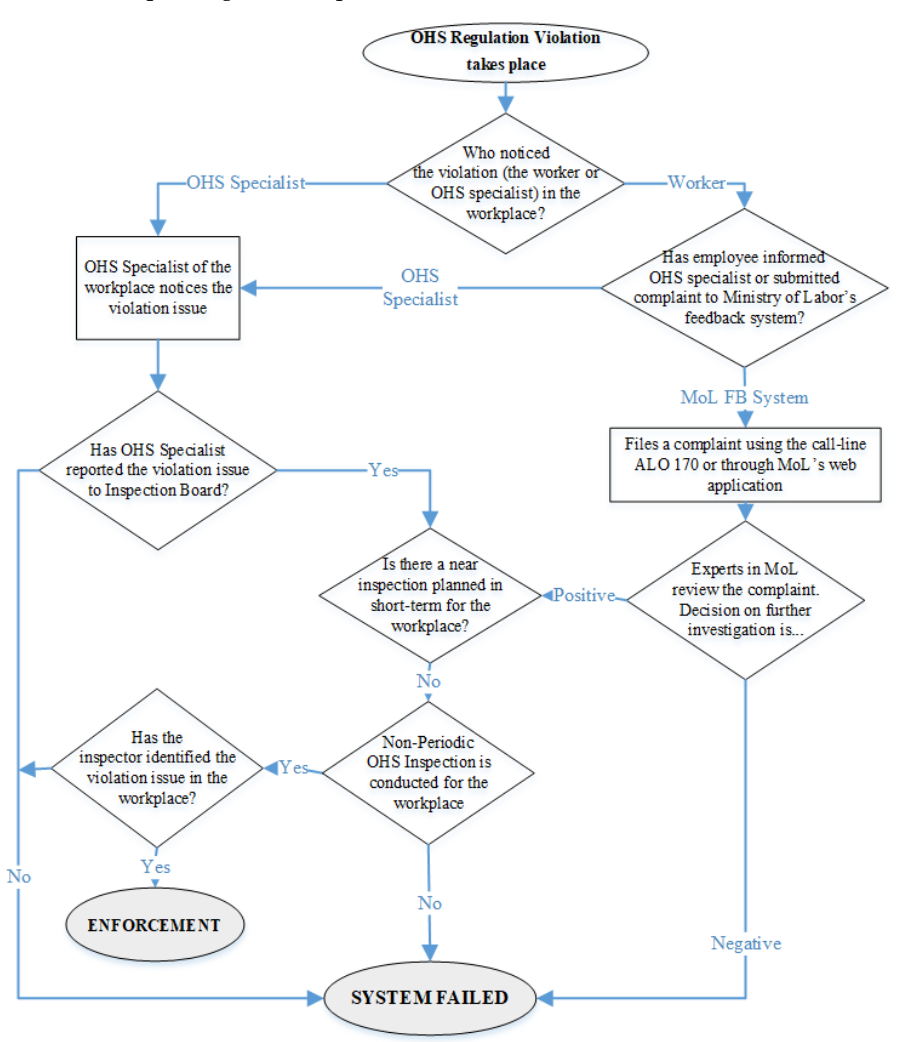
Figure 2. Process Flowchart of Institutional System for OHS Regulation Violations.